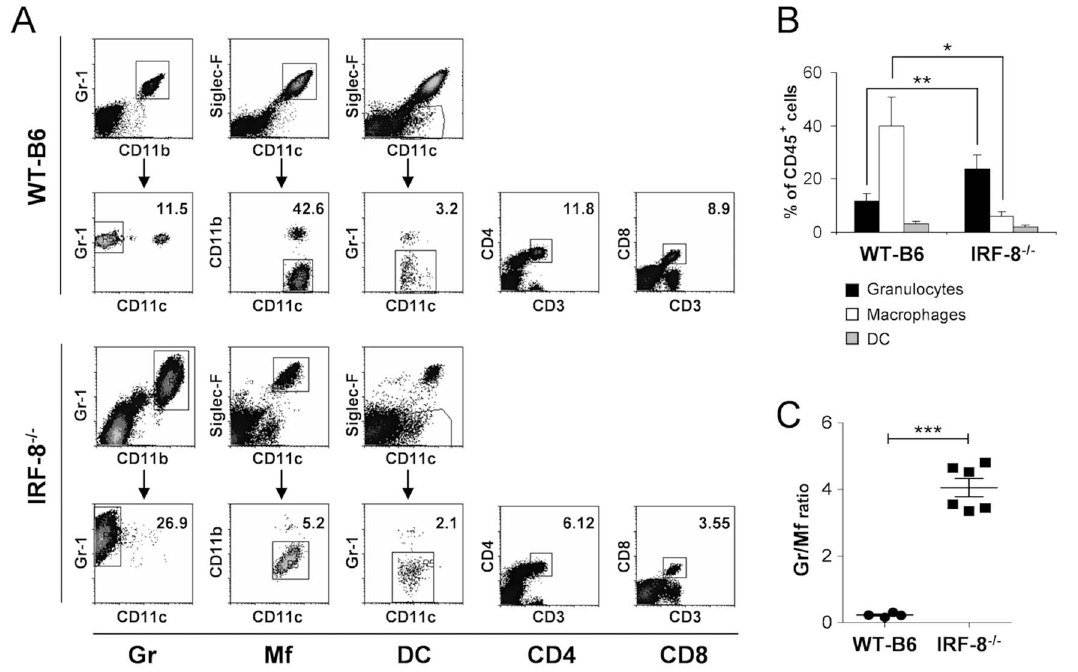
Figure 3. Immune cell distribution in lungs of uninfected IRF-8 2 / 2 vs. WT-B6 mice. Lung cells from naı¨ve IRF-8 2 / 2 and WT-B6 mice were labelled with a panel of fluorescent mAbs against the indicated surface markers. A) Representative FACS analysis of indicated cell populations. Upper panels show cells gated over total CD45 + leukocytes. Plots in lower panels show cell populations gated as indicated by the arrows. Numbers represent the percent values of each indicated cell population over total CD45 + cells. B) Mean percentages of lung granulocytes, macrophages and DC 6 SD (n=6 mice/group). * P , 0.05; ** P , 0.01. C) Ratio values between granulocytes and macrophages 6 SEM (n=6 mice/group). *** P , 0.001. Data are representative of one experiment out of four.